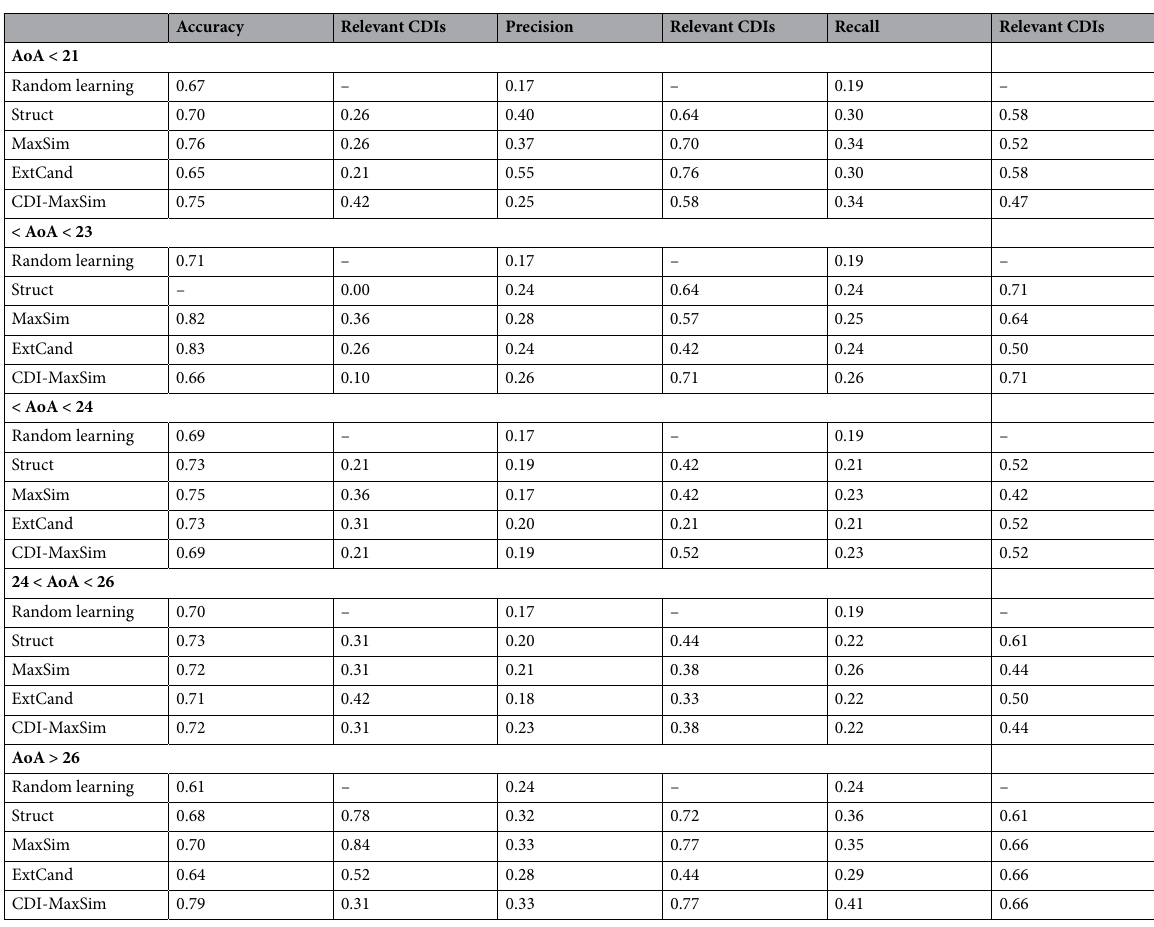
Table 1. Model performances over each bin of acquisition. Relevant CDI fraction is the ratio of statistically significant precision/recall values against a random learning